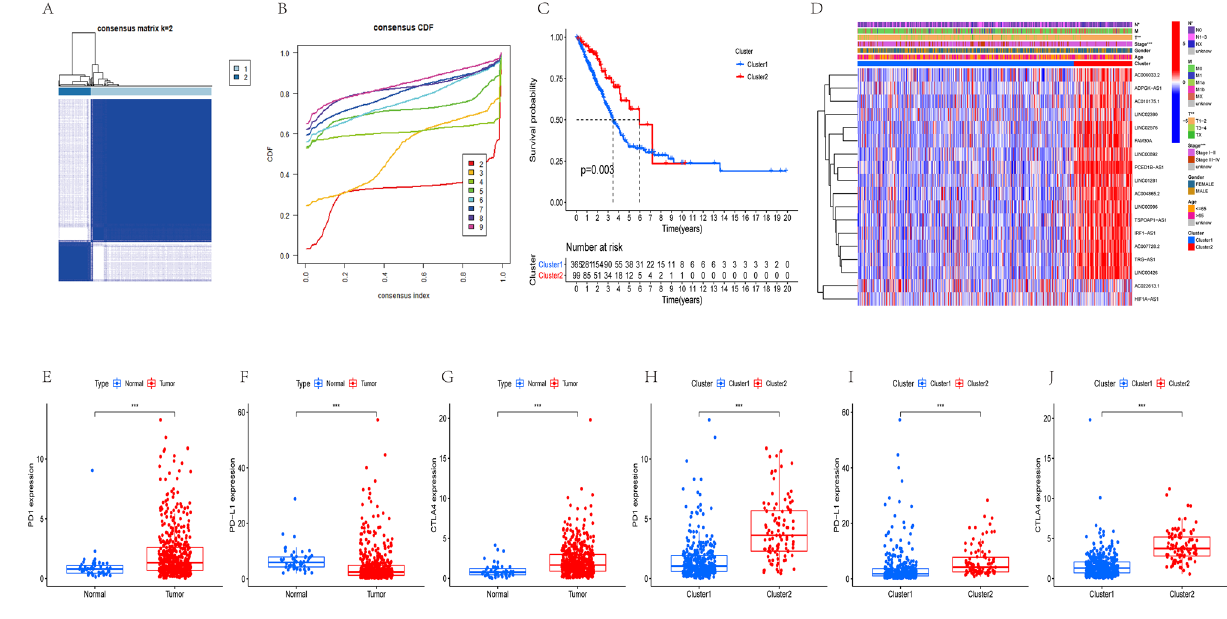
Figure 2. Identification of LUAD subtypes using NMF consensus clustering in LUAD patients. ( A , B ) NMF clustering using 18 IClncRNAs. The patients were divided into two clusters (Cluster 1 and Cluster 2). ( C ) Survival analysis of patients in Clusters 1 and 2 in the LUAD cohort. ( D ) Heatmap of two clusters defined by IClncRNA expression. ( E – G ) Differences in PD1, PD-L1, and CTLA4 expression between lung cancer tissue and normal tissue. ( H – J ) Differences in PD1, PD-L1, and CTLA4 expression between Cluster 1 and Cluster 2.